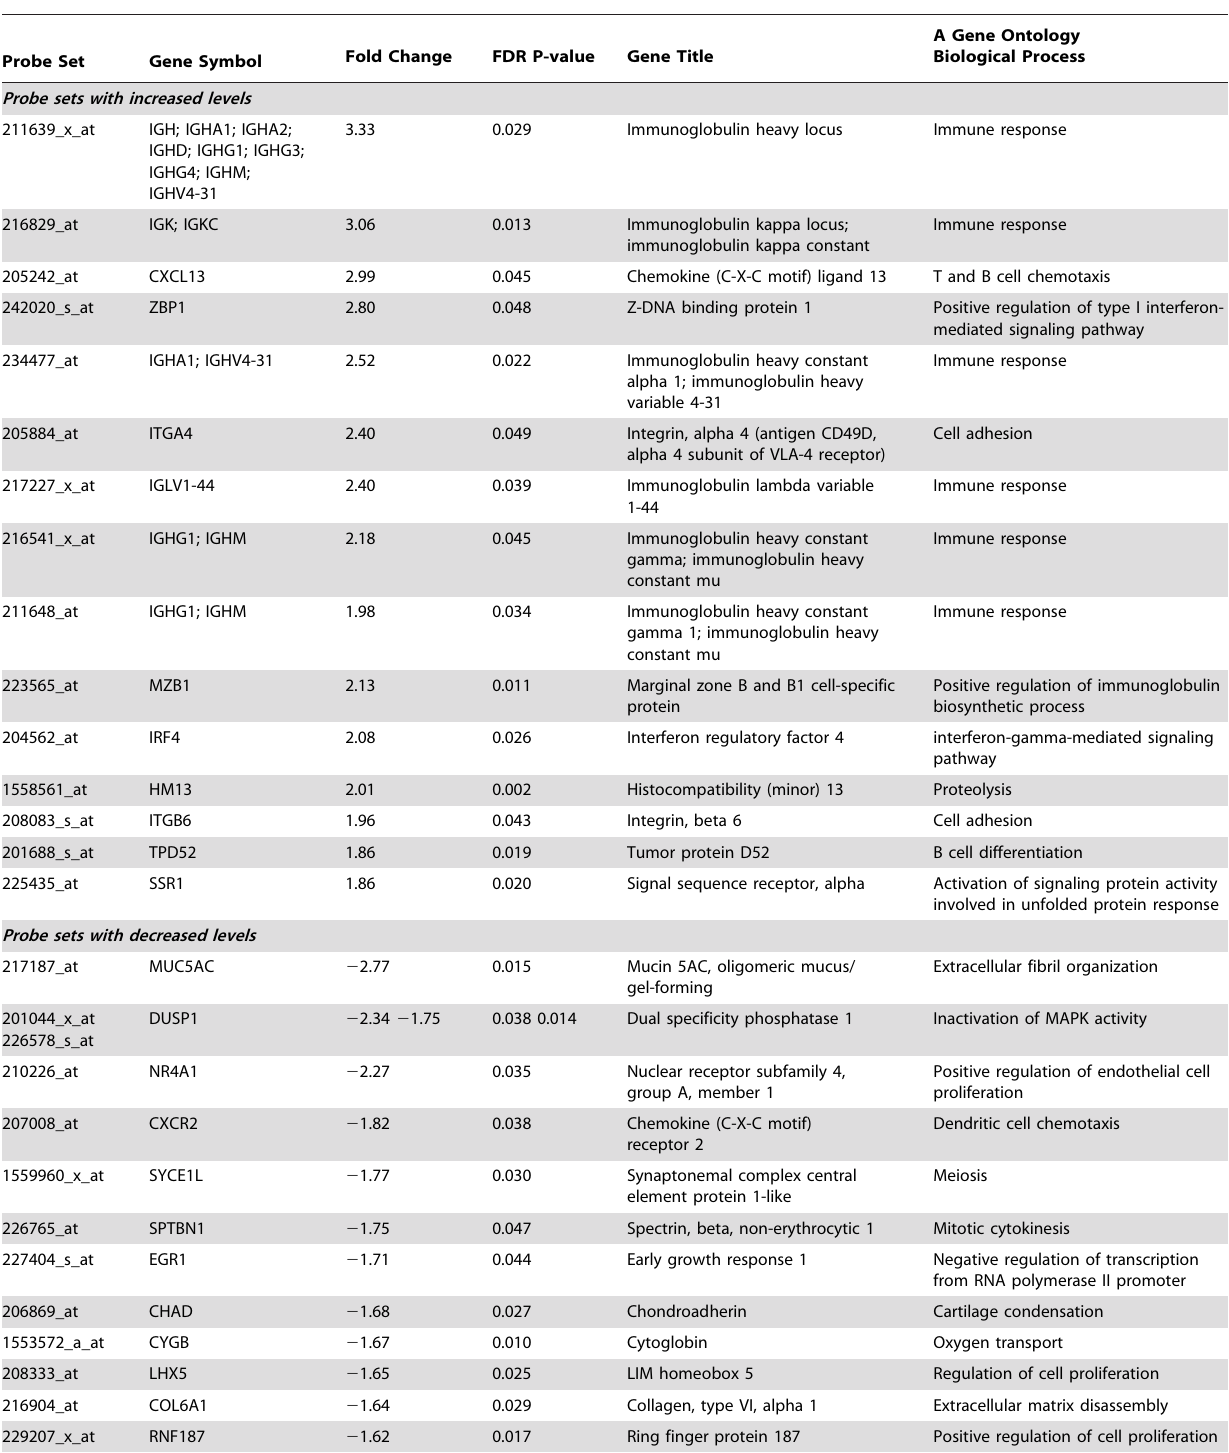
Table 4. Examples of gene expression differences comparing IgG4 + to IgG4- orbital tissue from subjects with NSOI, GPA, or sarcoidosis.